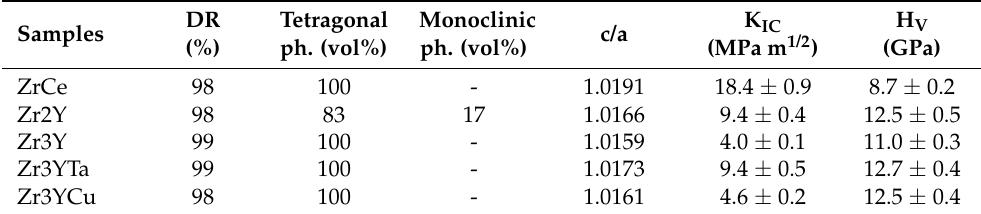
Table 2. Properties of zirconia-based materials doped with different stabilizers and toughening oxides. DR is the relative density, c/a is the tetragonality, K IC the fracture toughness, and H V the